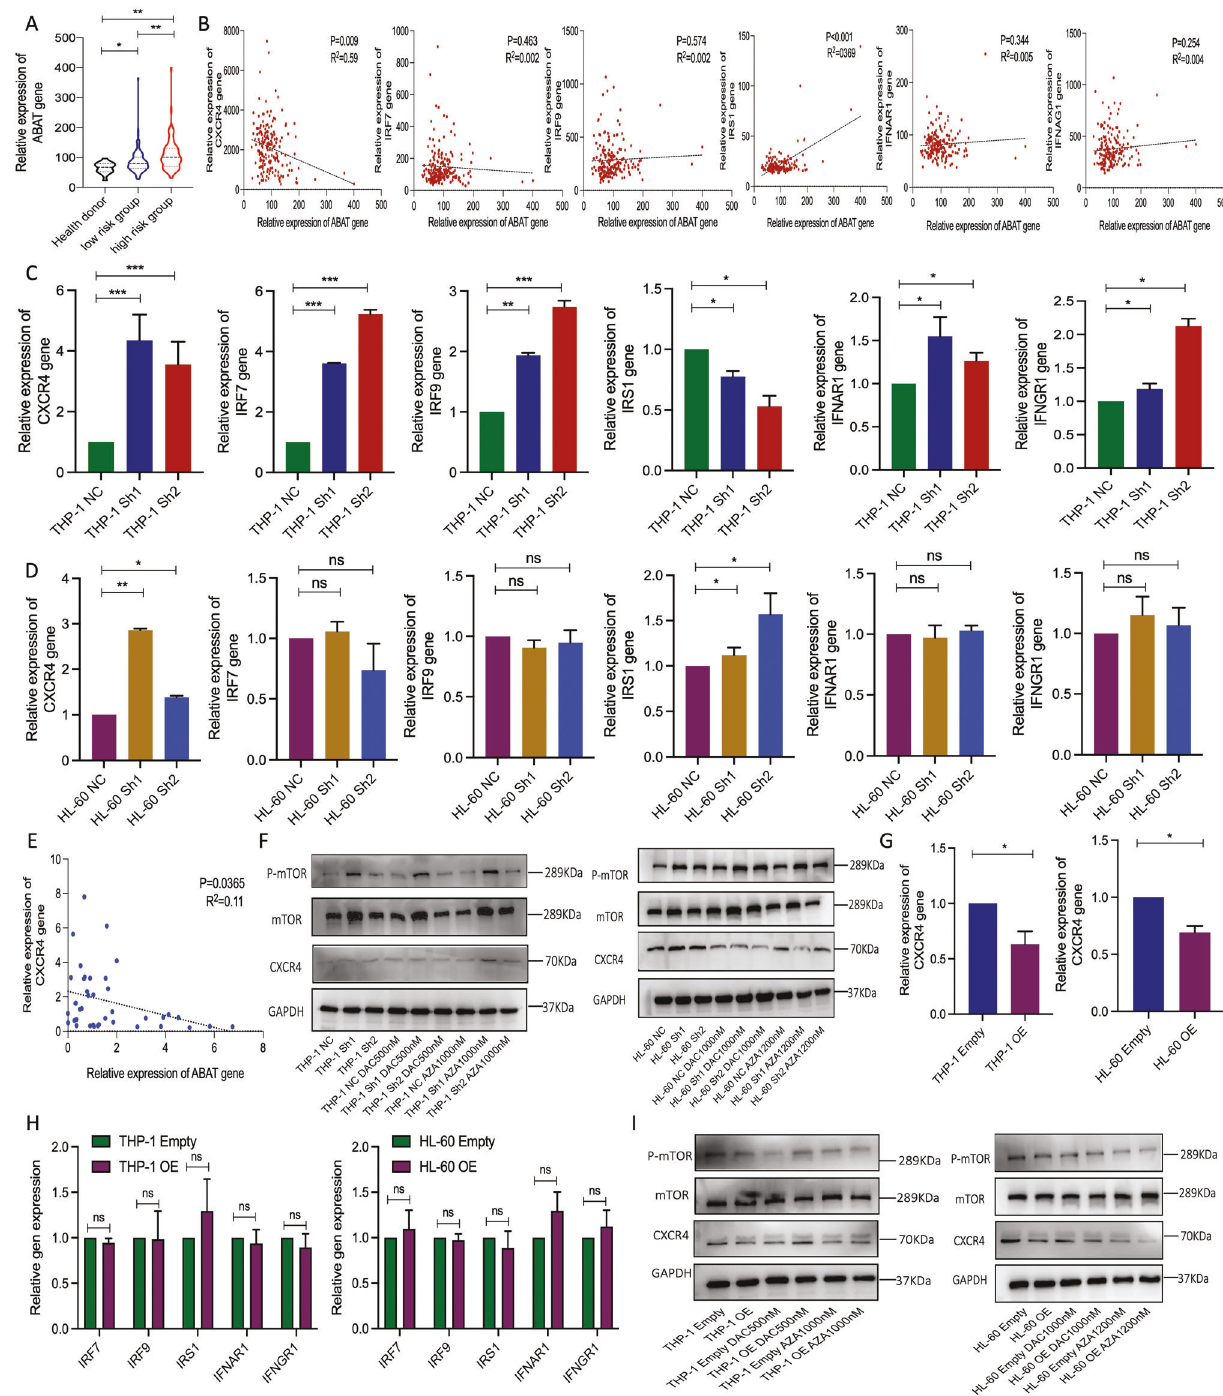
Fig. 4 CXCR4/mTOR signaling and ABAT gene expression analysis in cell lines and clinical samples. A ABAT gene expression was analyzed in the GSE19429 dataset. B Expression correlation analysis between ABAT and interferon response-related genes in the GSE19429 dataset. Relative expression of CXCR4, IRF7, IRF9, IRS1, IFNAR1, and IFNGR1 gene in ABAT silenced THP-1 ( C ) and HL-60 ( D ) cells. E Correlation analysis of ABAT and CXCR4 gene in MDS samples. F Protein expressions of p-mTOR, mTOR, and CXCR4 in THP-1 and HL-60 cells with ABAT knockdown and HMAs treatment. G CXCR4 gene expression after ABAT overexpression. H IRF7, IRF9, IRS1, IFNAR1, and IFNGR1 gene expressions in the above two cell lines with ABAT overexpression. I Protein expression of p-mTOR, mTOR, and CXCR4 in THP-1 and HL-60 cells after ABAT overexpression and HMAs treatment. Data were represented as mean ± SEM from three biological samples. * P < 0.05, ** P < 0.01, *** P < 0.001. Pearson correlation analysis, Student ’ s t -test (two groups), and one-way ANOVA analysis followed by Dunnett ’ s test (multiple groups). ns. not signi fi cant.